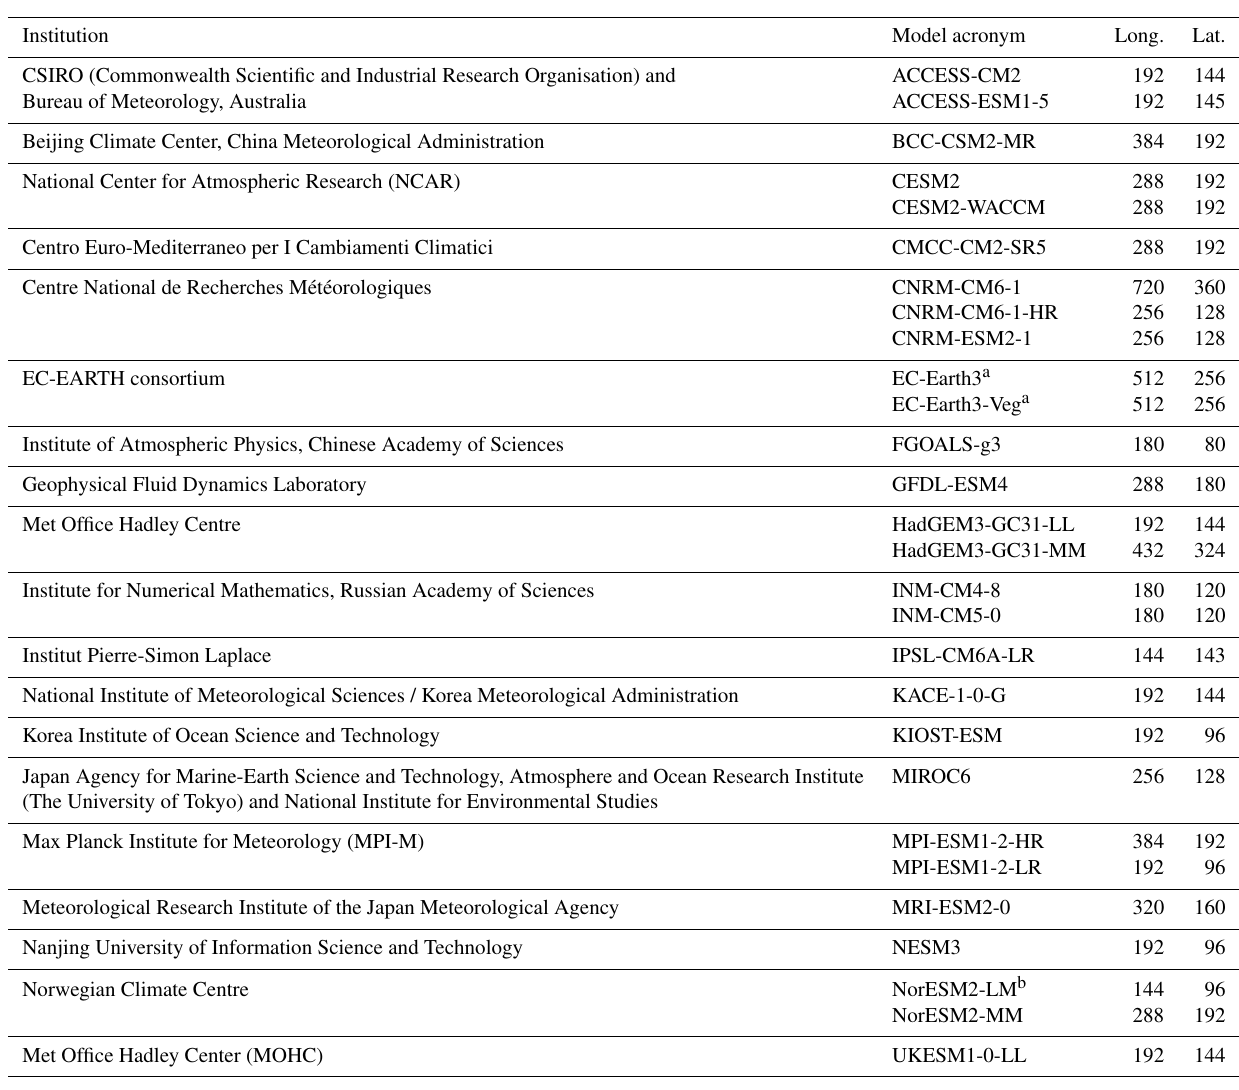
Table 1. CMIP6 models used in this study, showing the institution, model acronym, and horizontal grid resolution (number of grid points). Output from these 28 models is available at a monthly and daily